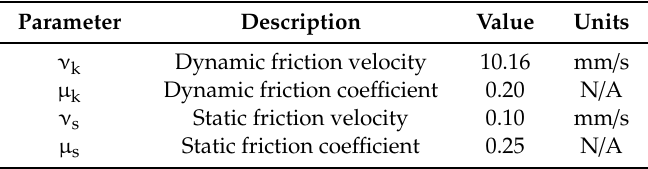
Table 3. Body contact parameters for the